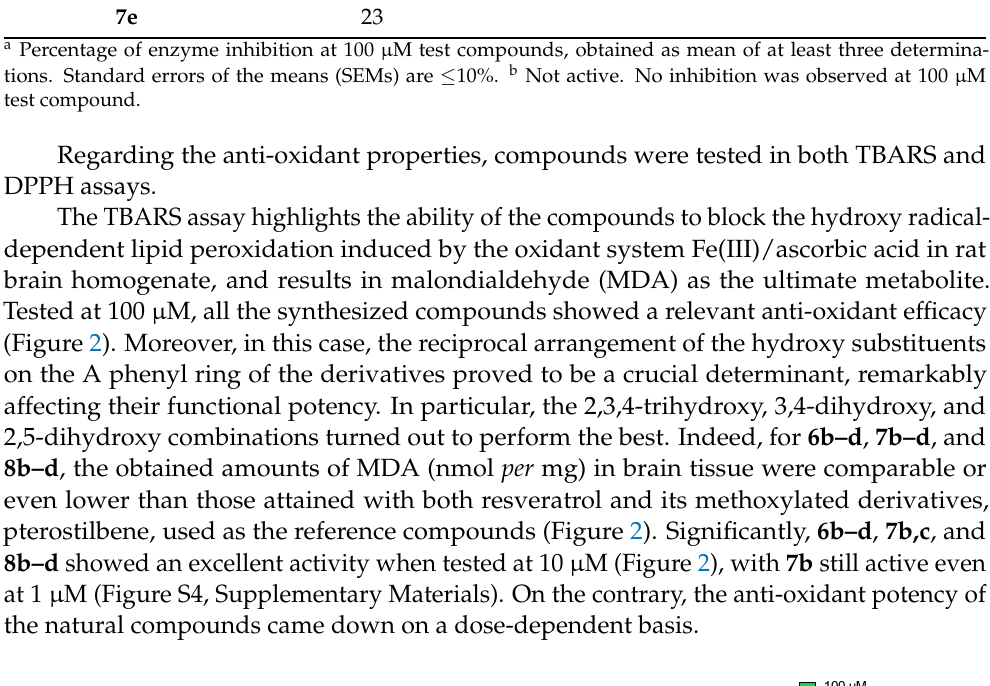
a Percentage of enzyme inhibition at 100 µ M test compounds, obtained as mean of at least three determina- tions. Standard errors of the means (SEMs) are ≤ 10%. b Not active. No inhibition was observed at 100 µ M test compound.